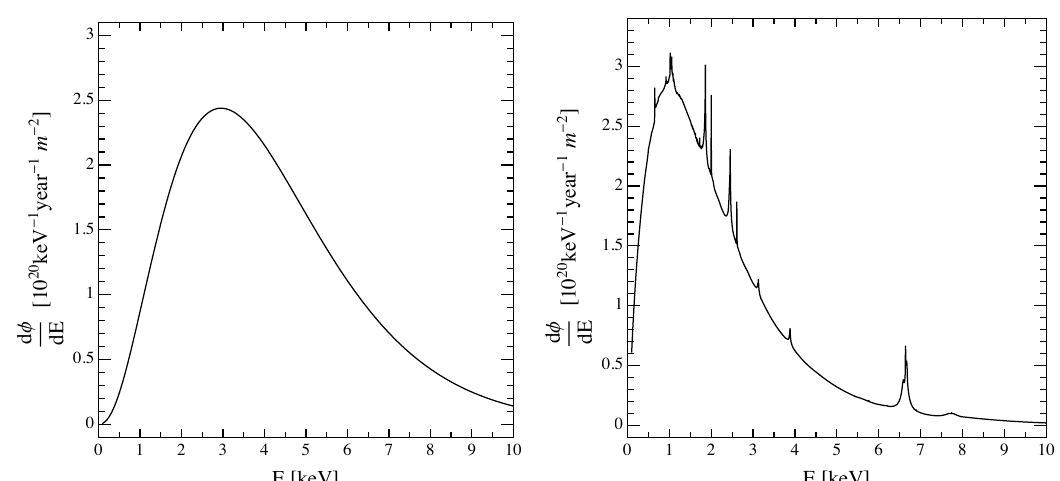
Figure 8: Solar axion flux spectra at Earth by different production mechanisms. On the left, the most generic situation in which only the Primakoff conversion of plasma photons into axions is assumed. On the right the spectrum originating from the ABC processes [ 82,203 ] . The illustrative values of the coupling constants chosen are = 10 − 12 GeV − 1 and g = 10 − 13 . Plots from [ 204 ] g a γ ae